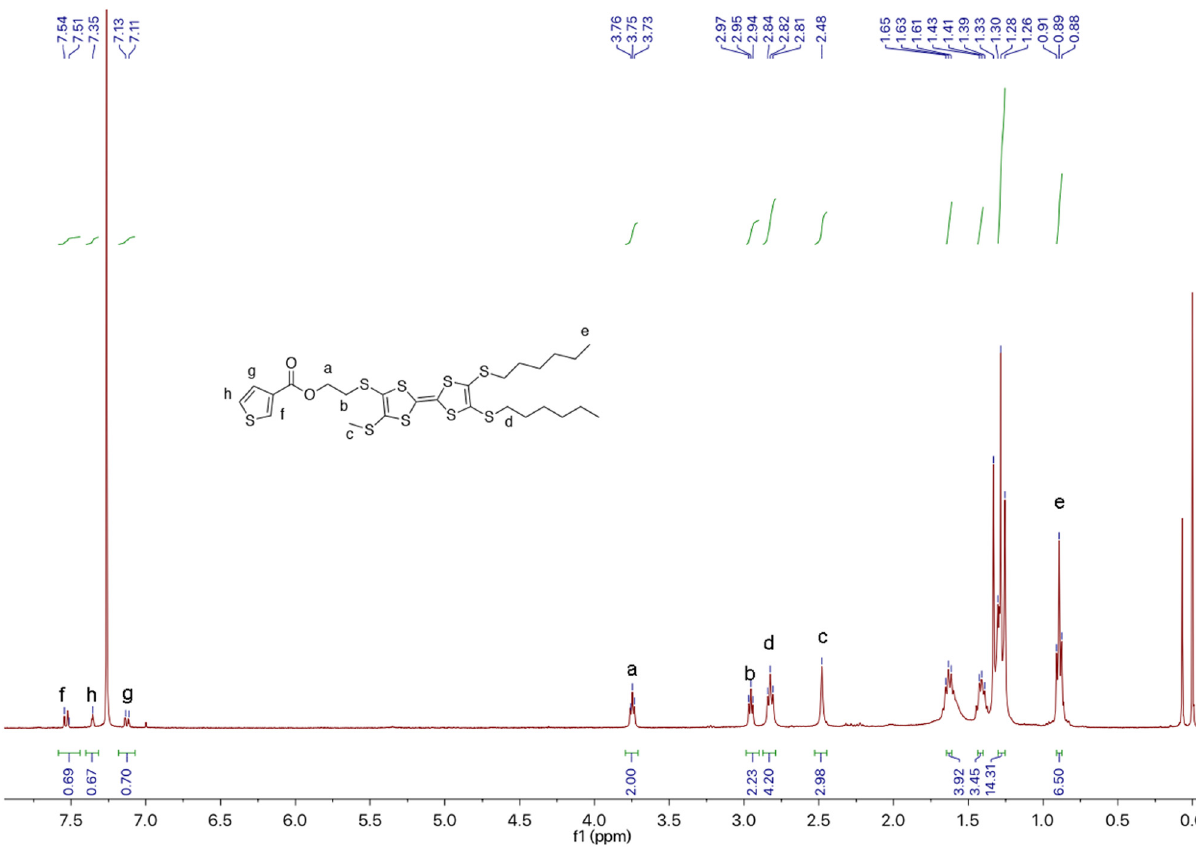
Figure A2: 1 H NMR of TTF - Th.